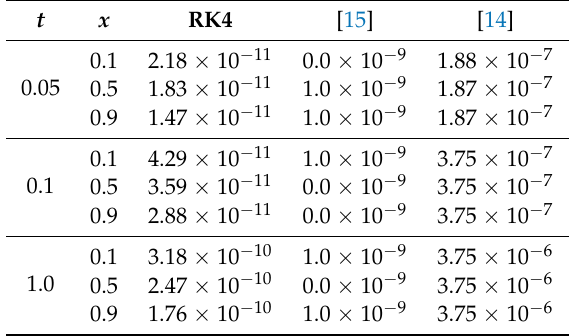
Table 5. Comparisons between the results obtained by the LMM with those adapted from [14,15] in term of L abs error norm for Test Problem 3.